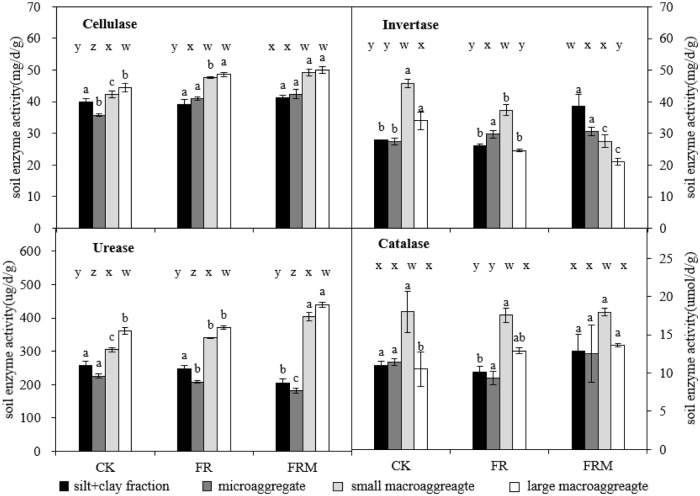
Compost and inorganic fertilizer effects on cellulase, invertase, urease and catalase activities in soil aggregates.Vertical bars denote the standard error of the mean (n = 3). Different letters a, b and c indicate significant differences between treatments at P < 0.05. Different letters w, x, y and z denote significant differences between aggregates for the same treatment at P < 0.05.